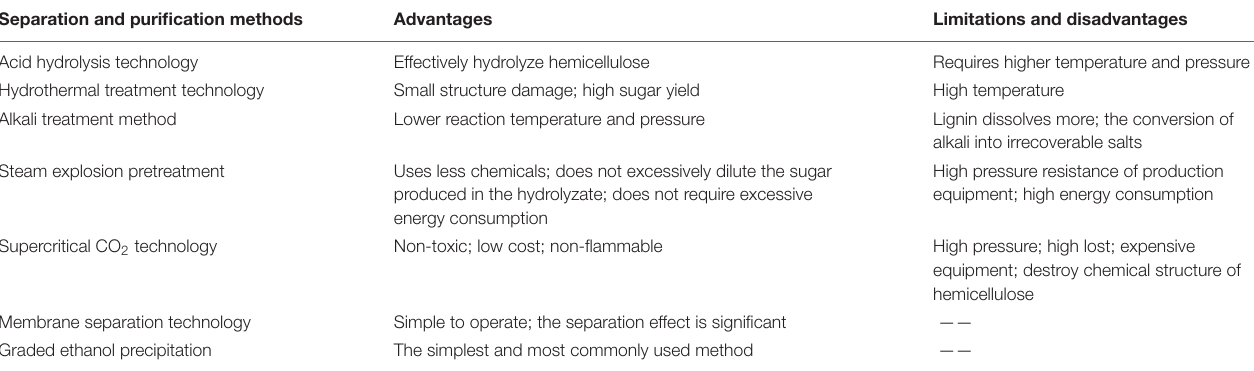
TABLE 1 | Summary of the separation and purification of hemicellulose from wheat straw. Separation and purification